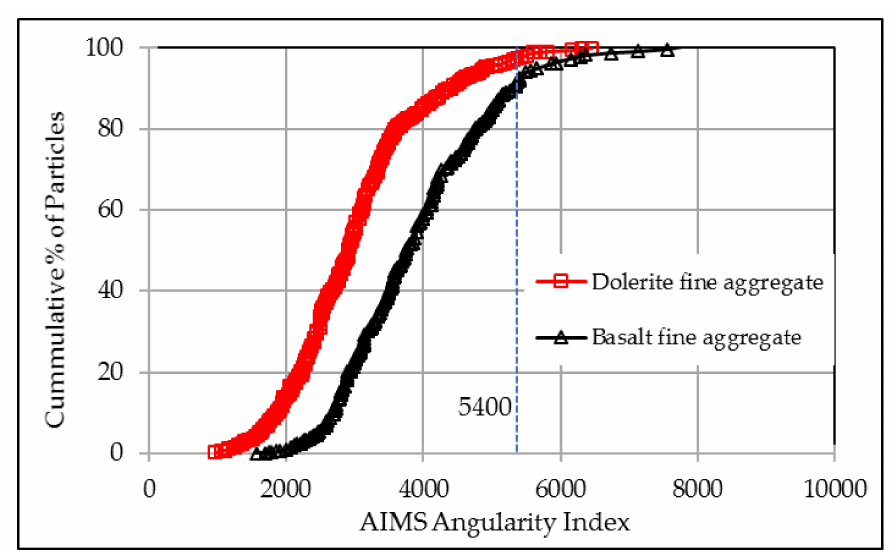
Figure 10. Angularity distributions of the fine aggregates